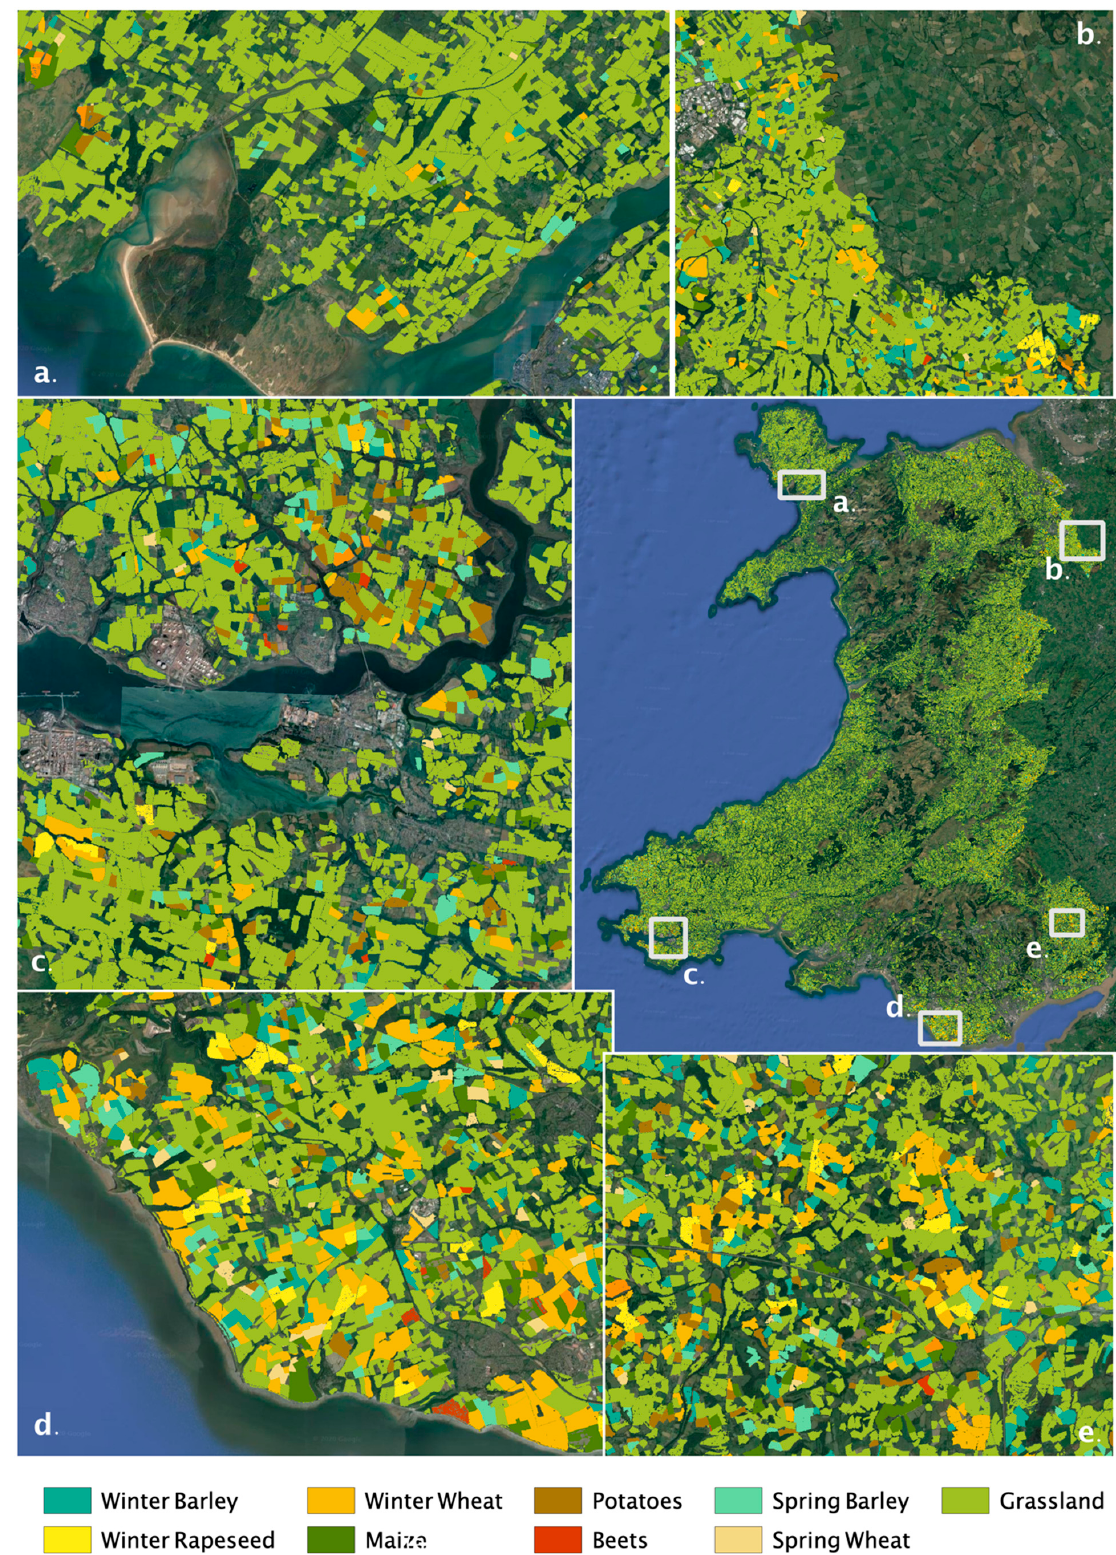
Figure 6. 2018 crop map for Wales obtained using the proposed methodology (i.e., knowledge-based), with zooms. Zoom ( a , b ) show Anglesey and Wrexham regions and zoom ( c – e ) show Pembrokeshire, Vale of Glamorgan, and Monmouthshire validation areas, respectively.